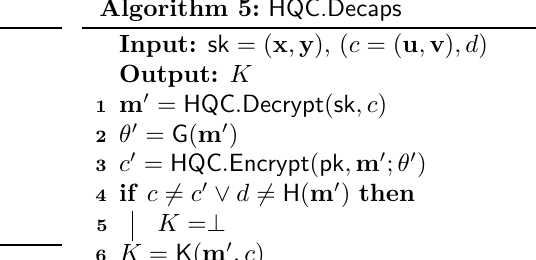
Algorithm 4: HQC.Encaps Algorithm 5: HQC.Decaps